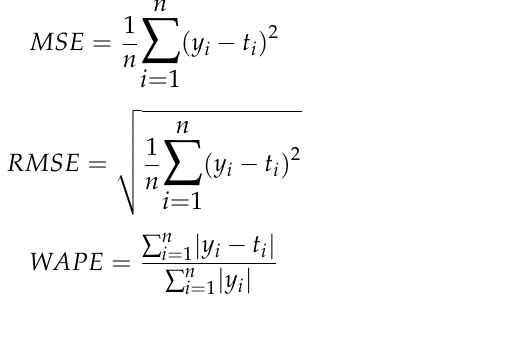
Figure 4. Value derivation method by CNN-LSTM.